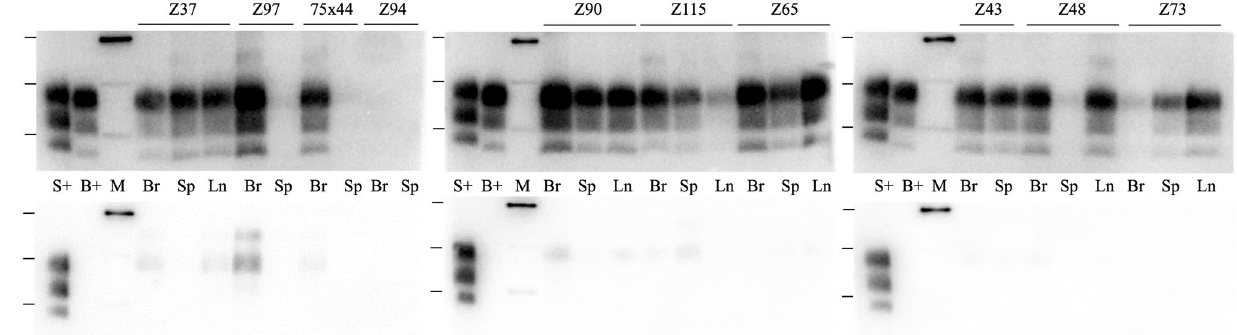
Figure 3. sPMCA amplification of BSE prions in sheep brain and LRS tissues. Following amplification of samples by sPMCA, PK-resistant PrP Sc was detected with either SHa31 (top panels) or P4 (lower panels). Representative blots are shown. Br brain, Sp spleen, Ln PSLN tissue. Scrapie (S+) and BSE (B+) brain controls were also analysed on each blot. Z37 and Z43 were ARQ/ARQ sheep inoculated with BSE only; Z97 was an ARQ/ARQ sheep inoculated with S/B; Z90, Z115 and Z73 were ARQ/ARQ sheep inoculated with S + B3m; Z94 was a VRQ/ARQ sheep inoculated with SSBP/1 only; Z65 and Z48 were VRQ/ARQ sheep inoculated with BSE only; sheep 75 × 44 had natural scrapie and was superinfected, NS + B8m. Molecular weight markers (M) are shown at 20, 30 and 40 kDa and positions are also indicated on each